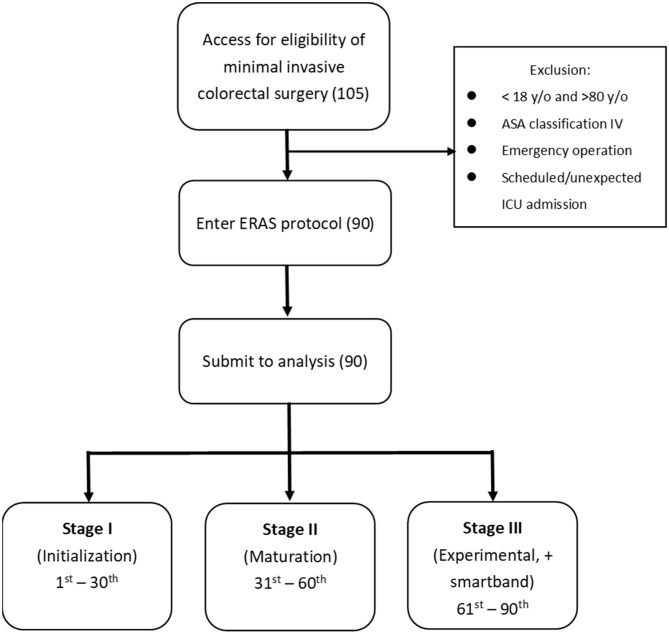
Consort diagram.